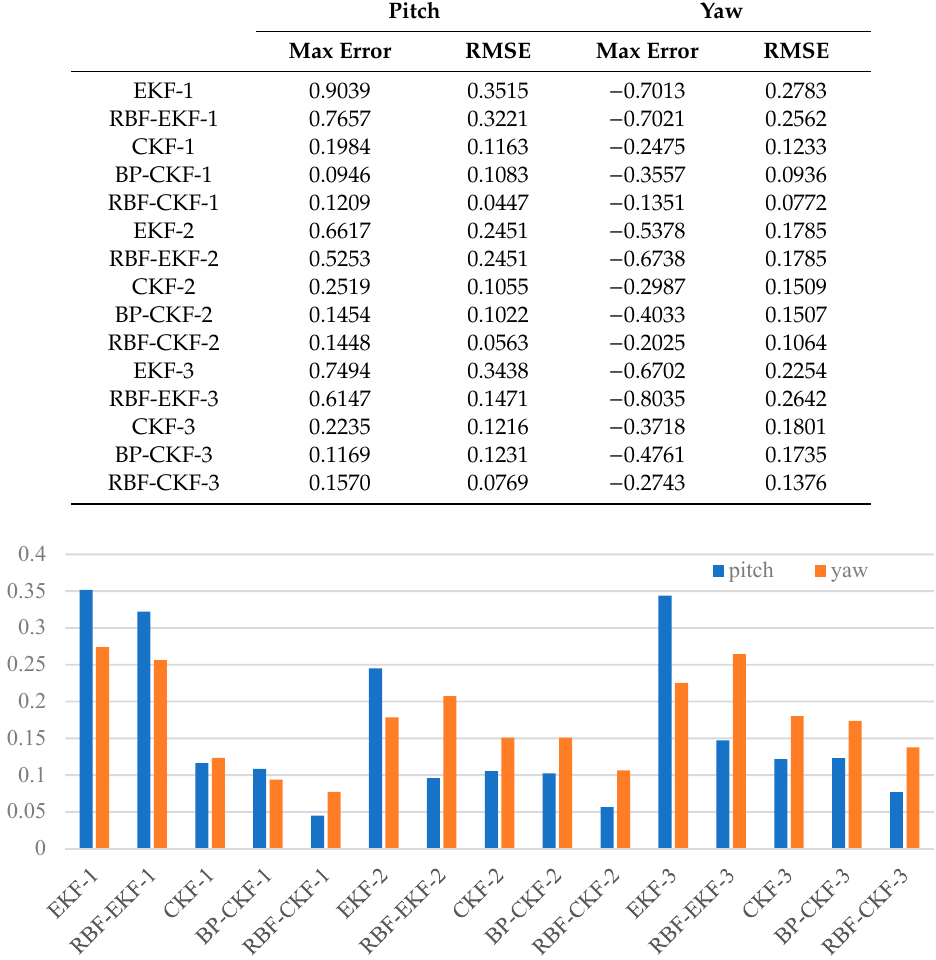
Table 2. Maximum errors and RMSE for di ff erent methods across three groups of experiments (degree).